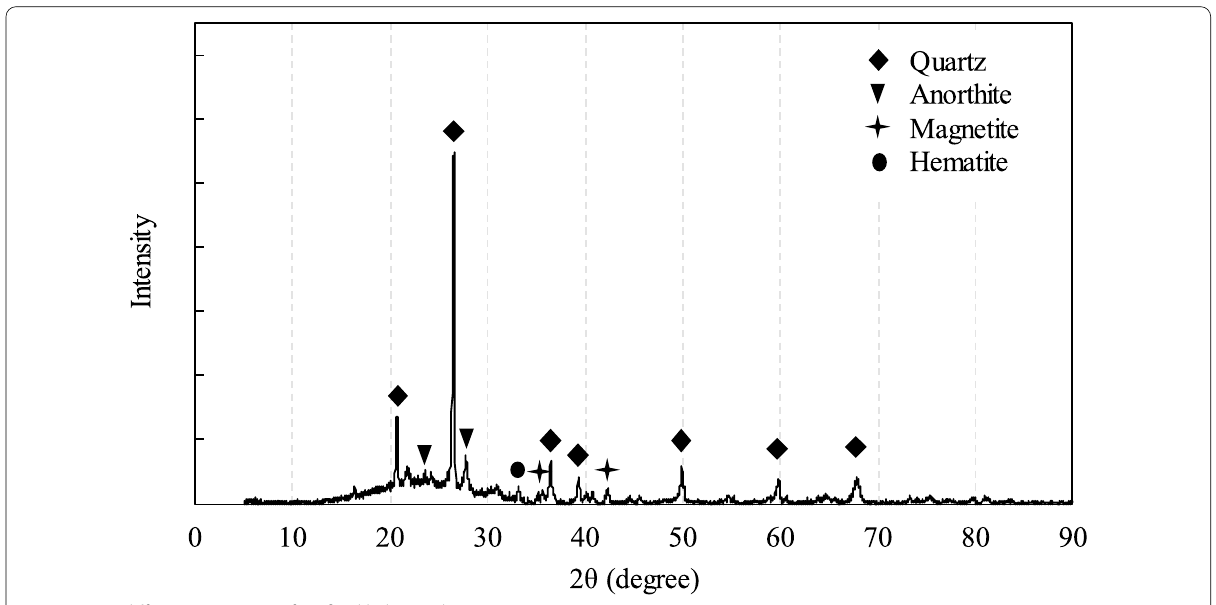
Fig. 1 X‑ray diffraction patterns of artificial lightweight aggregates.